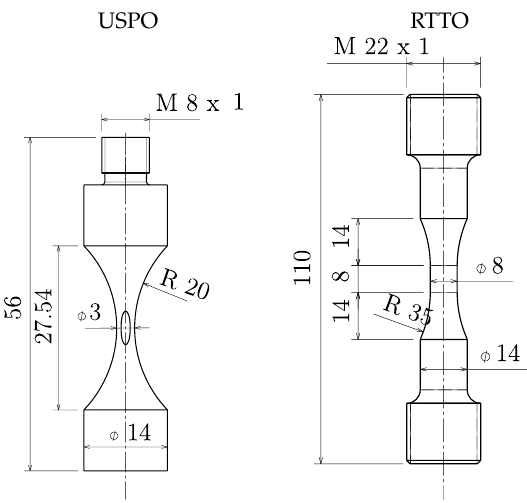
Figure 2. Geometry of specimens with ultimate tensile strength 1096 MPa and K = 1.2 [8,115].